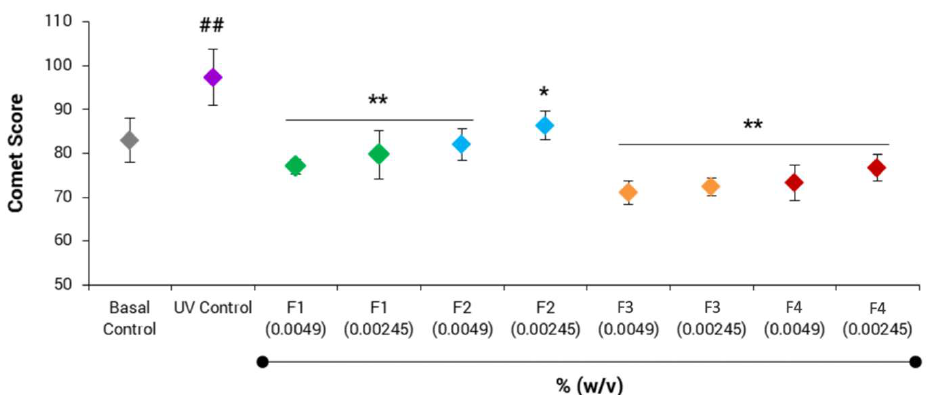
Figure 3. Evaluation of DNA protection potential of samples F1, F2, F3 and F4 in human keratinocytes after exposure to UV radiation. Data represent the mean ± standard deviation of three independent experiments. * p < 0.01 compared to the UV control group; ## p < 0.01 compared to the basal control group; ** p < 0.01 compared to the UV control group (ANOVA, Dunnet,